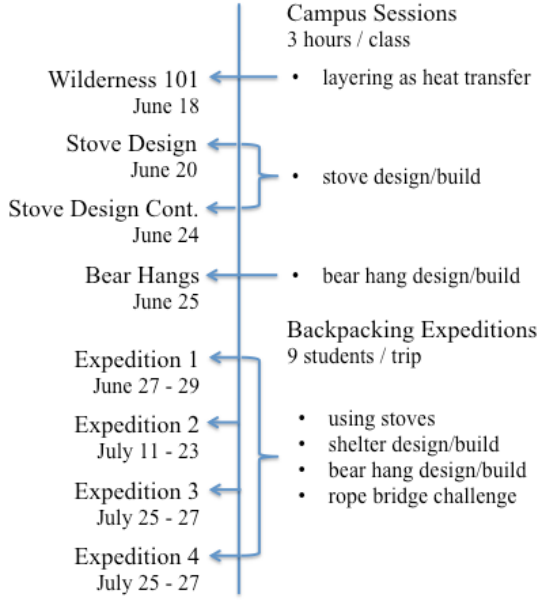
Figure 1. Timeline of design activities and